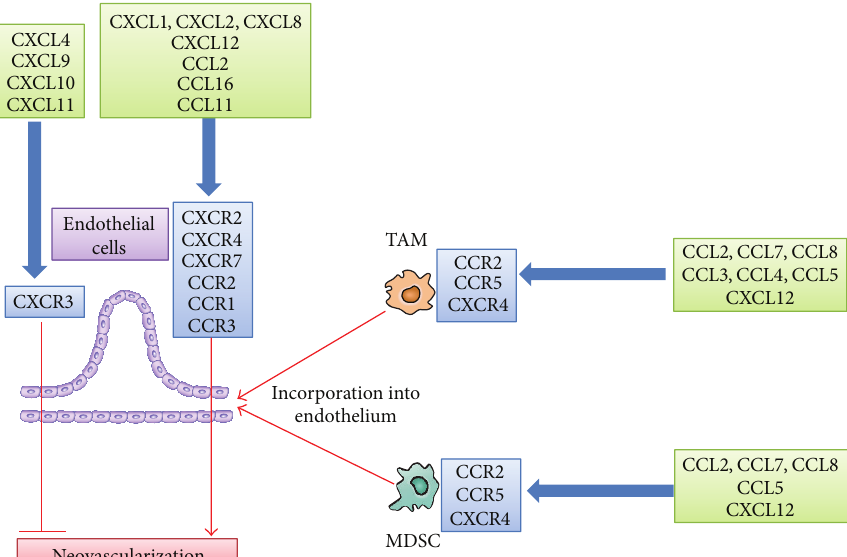
Figure 4: Chemokines acting on tumor